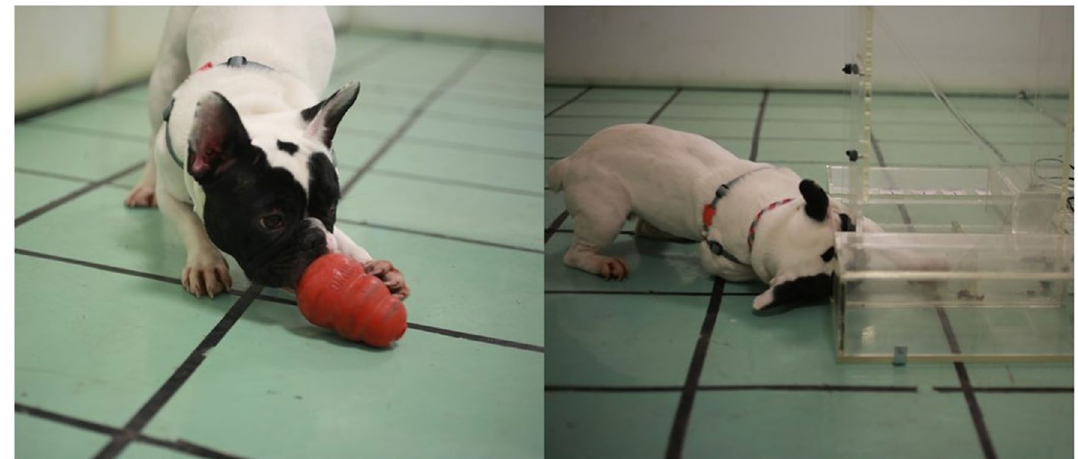
Figure 5. A dog performing Kong Test (on the left side) and Food-Reaching Test (on the right placed in the freezer at least 3–4 h before the test. The Kong toy was presented to the dog on a flat surface in the environment to be tested. Data analysis. Analysis of physiological parameters. Cortisol levels (see Fig. 1) were evaluated using a 2 × 2 mixed ANOVA with the between-subjects factor group (CS dogs/EH dogs) and the within-subjects factor condi- tion (baseline/OFT). Heart and respiratory rates were evaluated using a 2 × 3 mixed ANOVA with the between- subjects factor group (CS dogs/EH dogs) and the within-subjects factor condition (baseline/before OFT/after OFT). Cortisol levels were assayed using a commercially available competitive ELISA kit (Brand, Model, cat no). HUMAN brand COMBI WASH model washing device and NEXT LEVEL brand ALİSEİ model reading device were used. Cortisol was measured in ng/mL. Behavioral analysis for motor laterality tests. The video footage of the dogs obtained from the motor lateral- ity tests was analyzed by two trained and blinded raters. The percentage of interobserver reliability was always higher than 90%. To quantify individual paw preferences, an LI (laterality index) was determined using the formula LI = (R − L)/(R + L). R indicated the number of right paw uses and L the number of left paw uses. The LI had a range from − 1.0 (left paw use only) to + 1.0 (right paw use only). In addition to LIs, absolute LIs (absolute values of each Laterality Index) were calculated as an indicator of the strength of lateralization, regardless of pref- erence for direction. Since dogs have a higher rate of left-pawed animals than left-handed individuals do occur in humans, the absolute LI may be more informative in this species than the LI, since the LI effects for left-pawed and right-pawed animals may cancel each other out (e.g., if a reduction of asymmetry occurs in once condition). Whether or not dogs showed a significant bias in one direction for paw preference on the individual level was determined using binomial Z-scores for each dog [z = (R − 0.5 N)/√(0.25 N)]. According to the equation, N refers to the total number of paw scores, while R indicates the number of right paw scores. Dogs with a positive Z-score value (z ≥ 1.96) were scored as R-pawed, whereas those with a negative Z-score value (z ≤ − 1.96) were scored as L-pawed. Dogs with Z-scores between + 1.96 and − 1.96 were classified as ambilateral. Absolute LIs were calculated to investigate the strength of lateralization under stress, independent of the direc- tion of lateralization. Absolute LIs in FRT were evaluated using a 2 × 2 mixed ANCOVA with the between-subjects factor group (CS dogs/EH dogs) and the within-subjects factor condition (baseline/OFT). Sex was included as a covariate. Independent-samples t-tests were used to compare the LIs of male and female dogs for both tests. The alpha value for significance was set at 0.05. IBM SPSS Statistics 27 was used for all statistical analyses. Behavioral analysis of the OFT by DeepLabCut. In order to get a deeper insight into dog behaviors in the OFT were evaluated through the movement trajectories captured with ‘DeepLabCut’, an open-source python toolbox using deep neural network 51 . Frame-by-frame body positions were tracked with DeepLabCut (Fig. 5). The extracted x–y coordinates were smoothed using the spline function to remove the effect of tracking failure before analysis. Two metrics were calculated from the stream of body movement: average movement speed and distance to the novel object. The movement speed was considered as a proxy of an activity level in the Open Field Test, similarly to the previous study 82 . It was defined and computed as moment-to-moment subtraction between successive trajectories of each video frame. Next, the average distance from the body to the novel object was quantified, which reflects the approach and avoidance tendency during the OFT. That is if the novel object invokes curiosity, or conversely, fear, animals might show approach or avoidance responses to it. These behaviors must be reflected in the distance metric to the object. Thus, body-to-object distance from obtained x–y coordi- nates was calculated (Supplementary Video 1). Furthermore, animals typically show distinct patterns between active and pause states in the speed profile over the time course of the OFT. Therefore, active, and resting patterns were classified, and for each dog, the